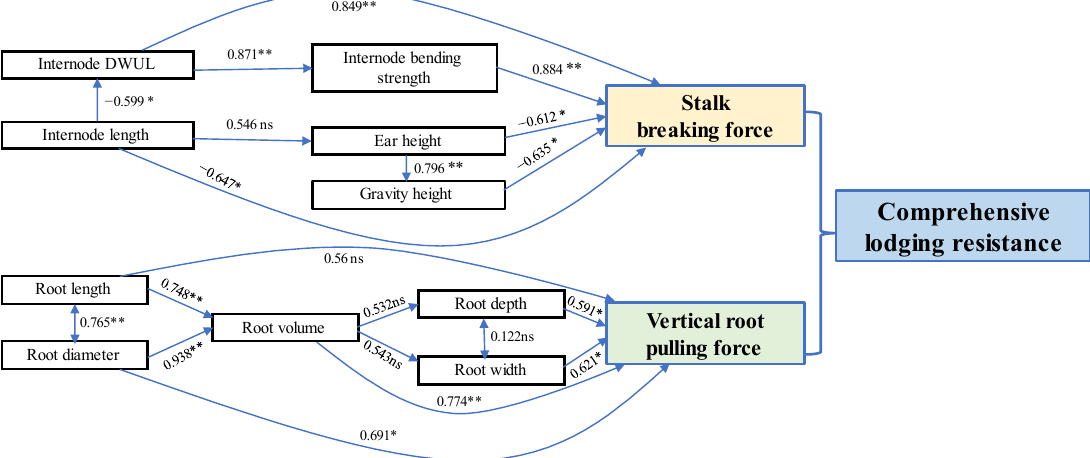
Figure 7. Path correlation analysis of the stalk breaking force, plant morphology traits, stalk me- chanical strength, and morphological root traits ( n = 12). An arrow that points from one variable to another means that the first variable affects the second, and a double-headed arrow means that the two variables covary. Numbers on the lines are path coefficients. * p < 0.05; ** p < 0.01; ns, no signif- icance.